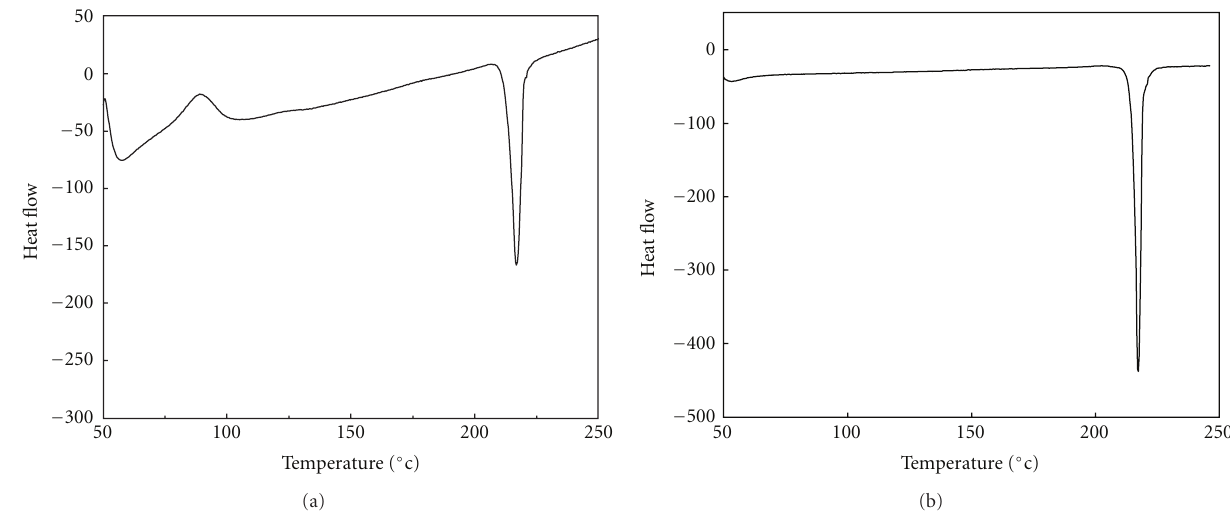
Figure 5: DSC thermogram of (a) the selenium nanoparticles synthesized by the reaction of 1 . 0 × 10 − 3 moldm − 3 sodium selenosulphate with 2 . 0 × 10 − 2 moldm − 3 acetic acid, in the presence of 0.01% PVA, and (b) standard commercial selenium sample.